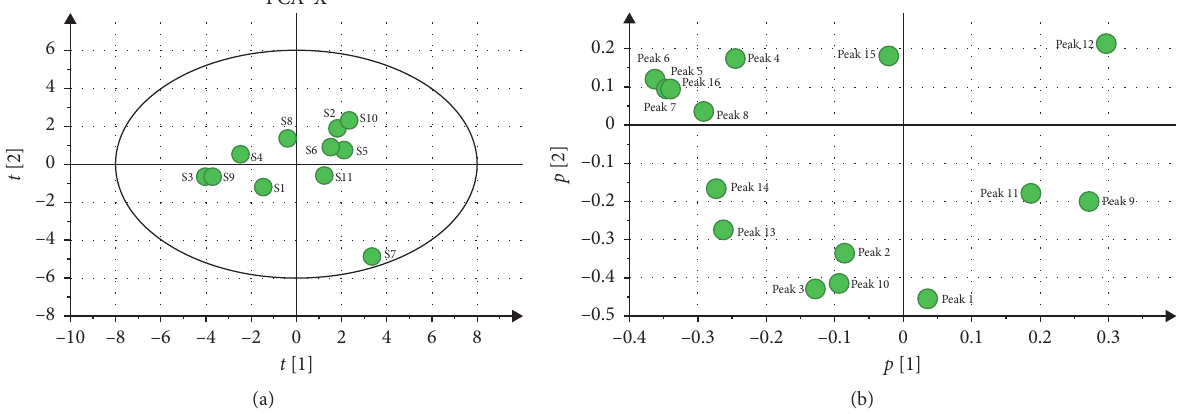
Figure 3: PCA analysis of 11 batches of AMR. (a) PCA scatter plot of 11 batches of AMR. (b) PCA load diagram of 11 batches of